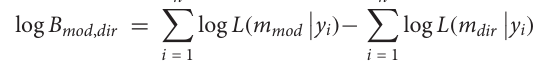
Connection 1 and Connection 2 in D are estimated.